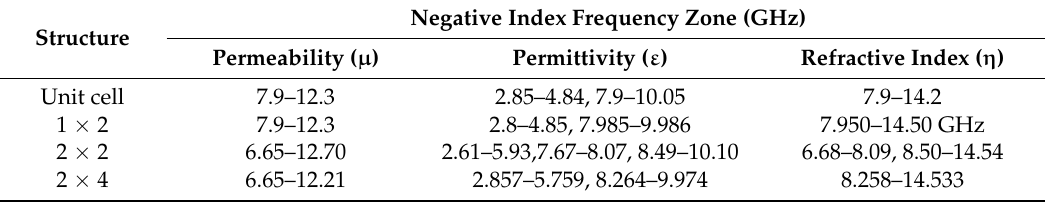
Table 2. Metamaterial (MTM) effective parameters ( µ , ε , η ) in the negative index frequency zone.